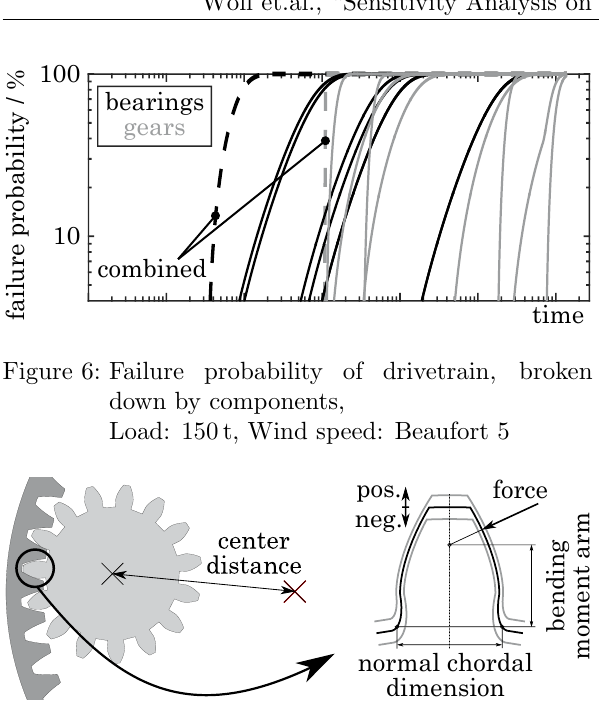
Figure 7: Center distance and profile shift